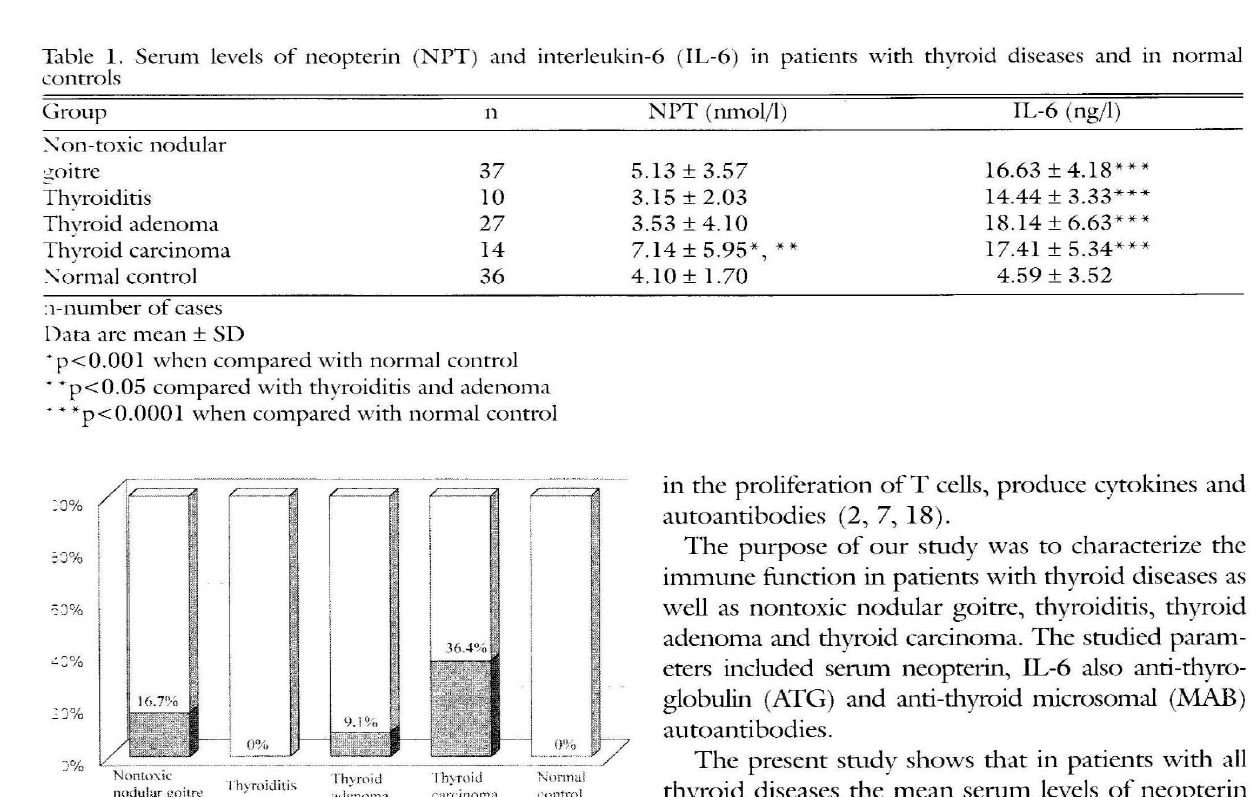
Figure 1. Percentage of patients with thyroid diseases and :ll control group with serum levels of neopterin higher :han 10